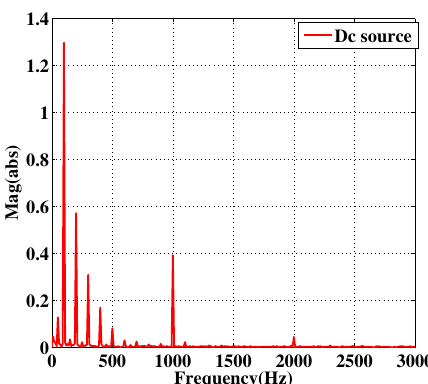
Figure 24. FFT plot of power source, v o